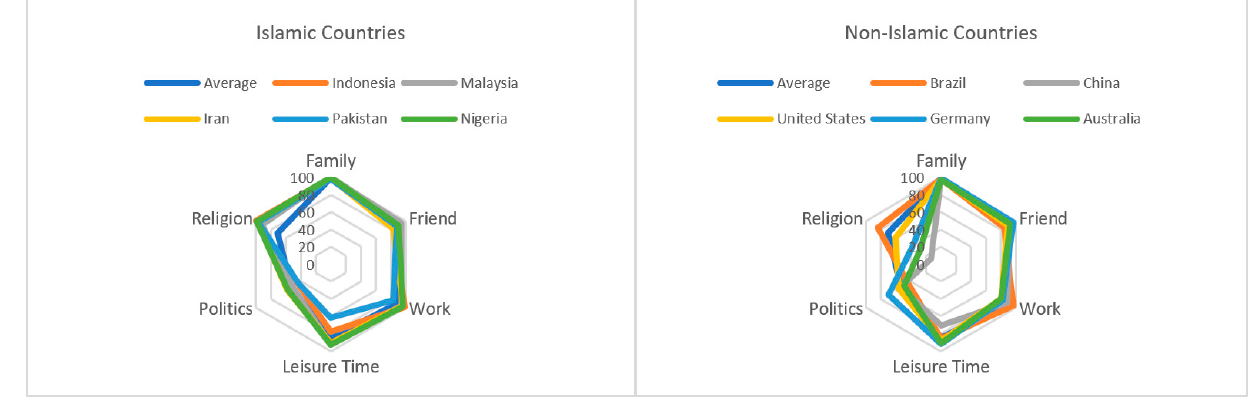
Figure 3. Important values in life by Islamic and non-Islamic countries.